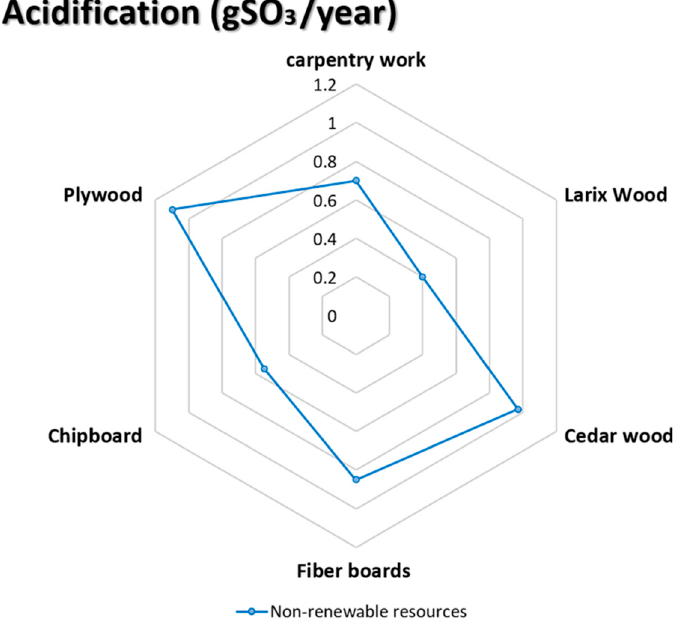
Figure 8. The impact of acidification on the selective façade wooden material [68–72].